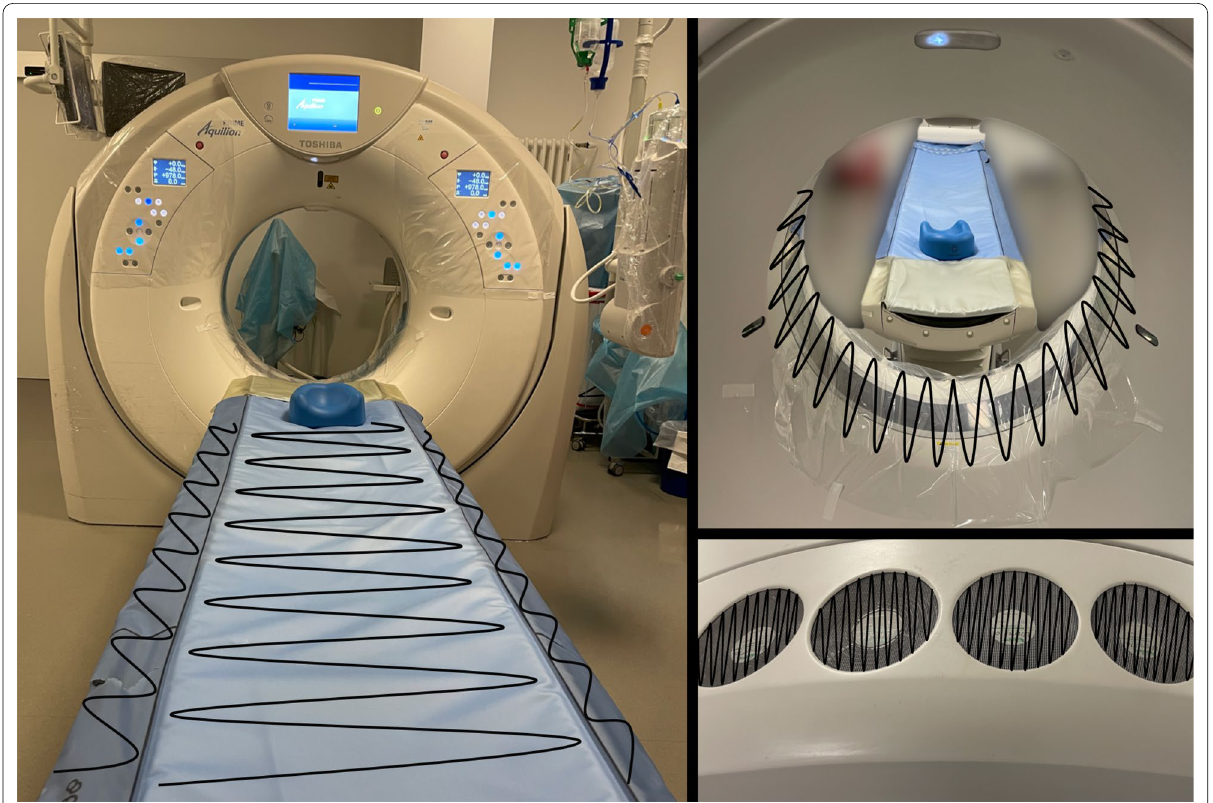
Fig. 1 Schematic presentation of sampling procedure. Black lines: paths of swap sampling on CT table, CT gantry and CT ventilation system air grid. CT gantry was wiped off